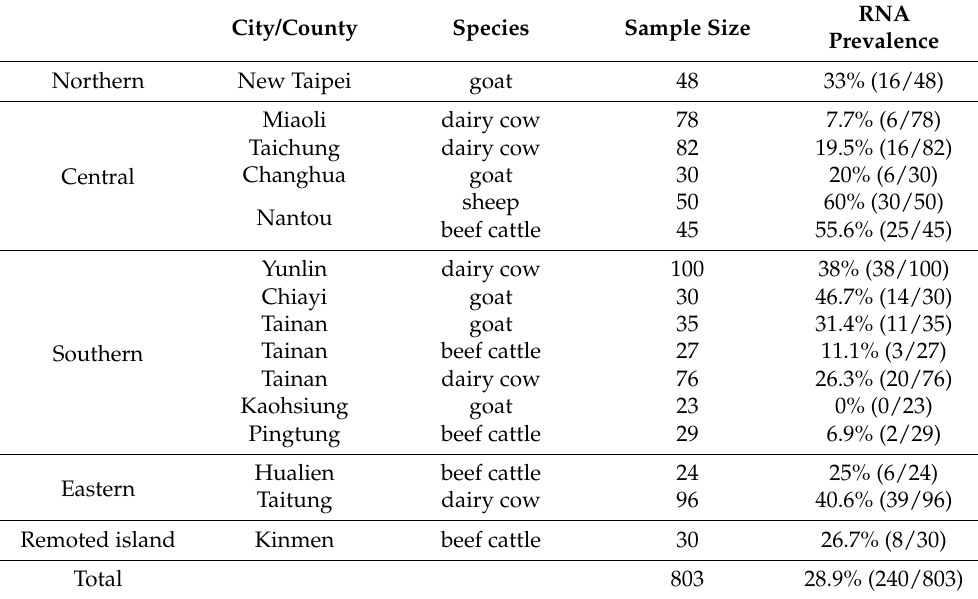
Figure 1. Map of Taiwan showing the location and number of ruminants enrolled in the study for SFTSV viral RNA detection. In total, 803 serum samples were collected from dairy cows, beef cattle, goats, and sheep in 15 cities in Taiwan. The numbers with specific symbols (superscript letters B, S, or underlined) indicate beef cattle, sheep, or goats, respectively, while the number of dairy cows is shown without any symbol. Table 2. Prevalence of SFTS viral RNA on ruminants in each